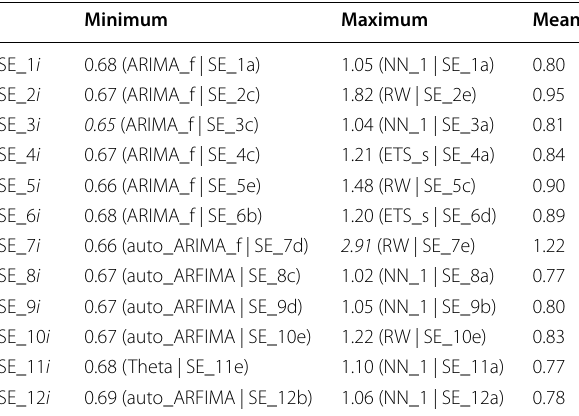
Table 16 Minimum, maximum and mean values of the MdoAE within the simulation experiments